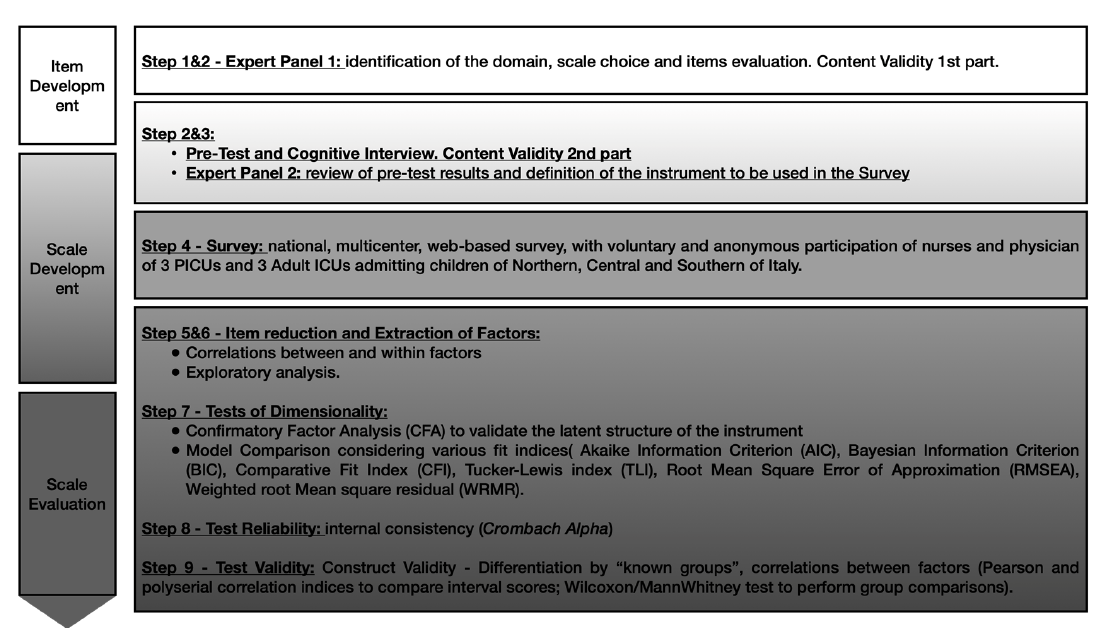
Figure 1. Study design. The study methodology follows the nine-step Boateng’s approach for developing and validating scales for health, social and behavioral research [18].